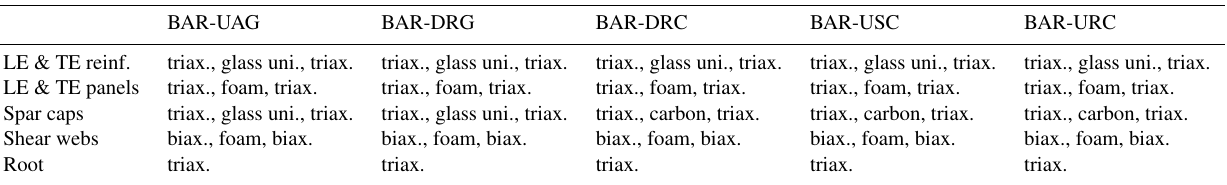
Table 4. Materials used in each component. LE denotes leading edge; TE denotes trailing edge.